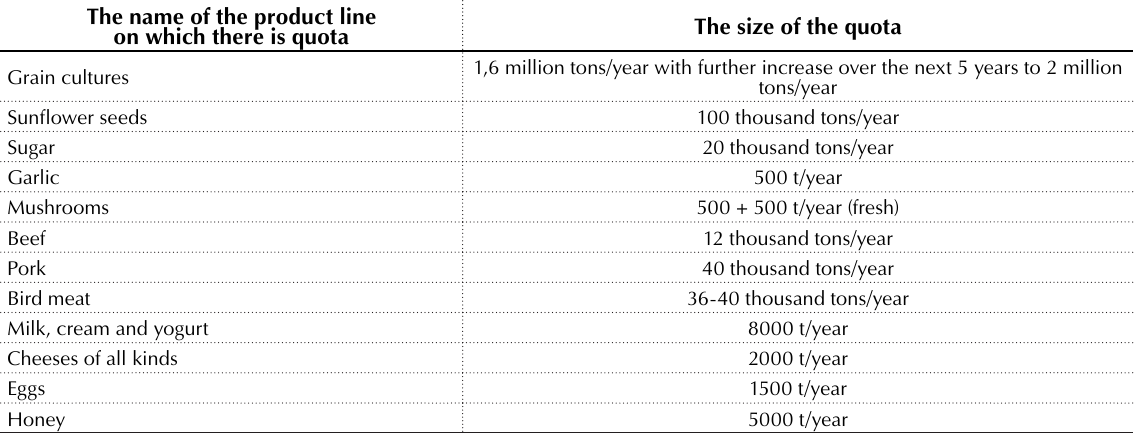
Table 1. Tariff quotas for agro-food products provided to Ukraine within the framework free trade zone with the EU Source: Developed by the authors based on State Statistics Service of Ukraine data (2018).